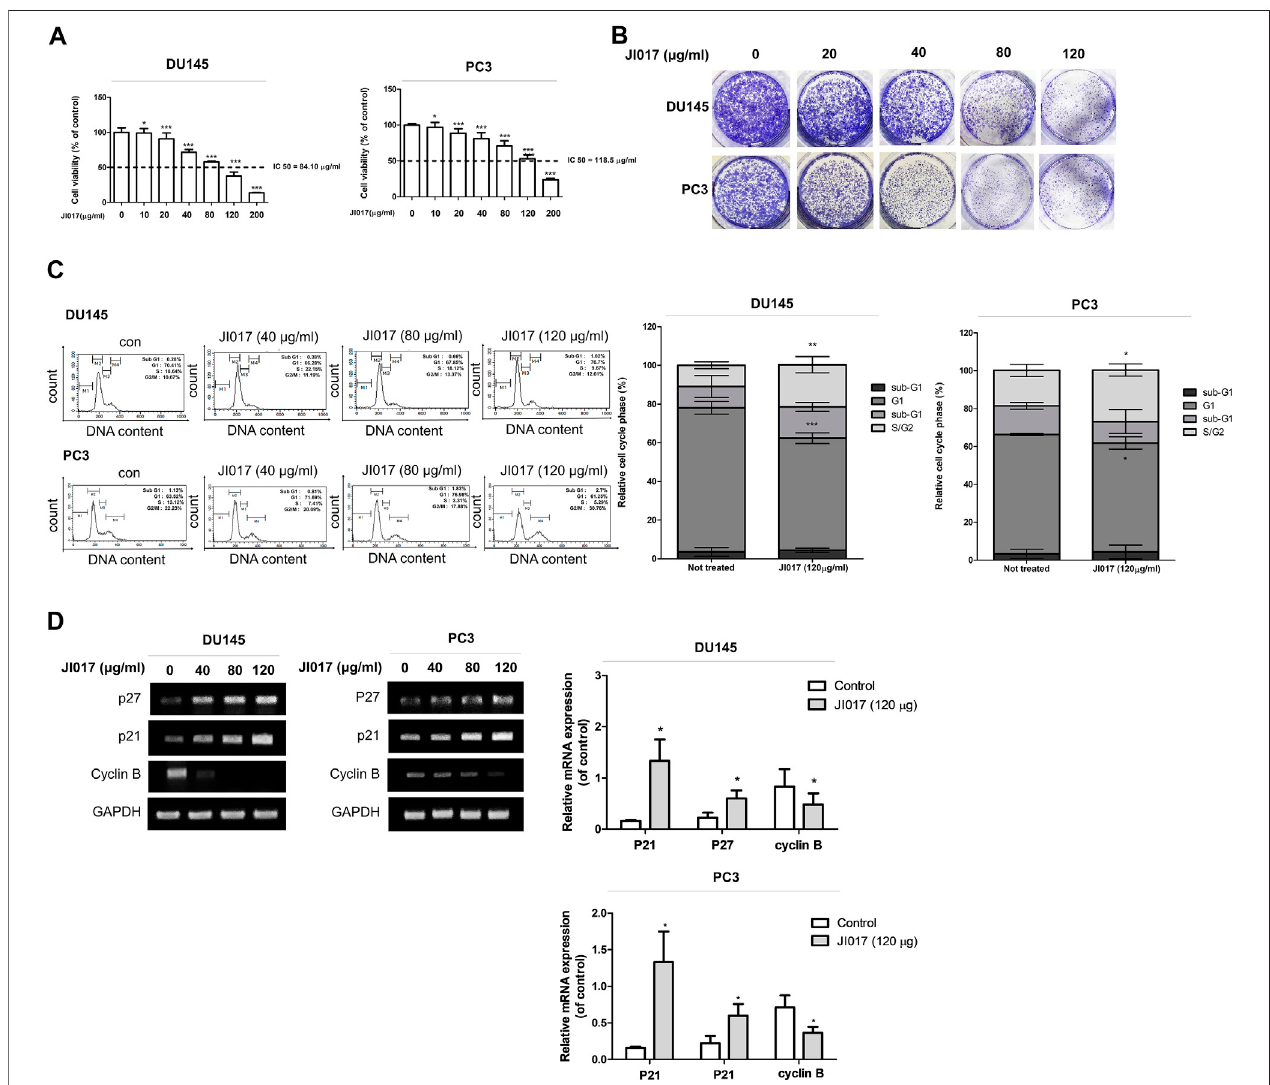
FIGURE2| Theanticancereffect ofJI017treatmentinducedtheG2/Mcellcyclearrestand apoptosisofDU145andPC3cells. DU145andPC3cellsweretreated withJI017(40,80,120,and200 μ g/ml)for24 h (A) .Cellviabilitywasmeasured byMTSassay.DU145and PC3cellswereexposedtoJI017(40,80,and120 μ g/ml)for 14 days (B) . Cellcycledistributionwasanalyzed using fl owcytometry (C) . Theexpression ofp21, p27, andcyclinBmRNA wasmeasured byRT-PCR (D) .The dataare presented as the mean ± SEM. * p < 0.05, ** p < 0.01, and *** p < 0.001 compared to untreated cells.